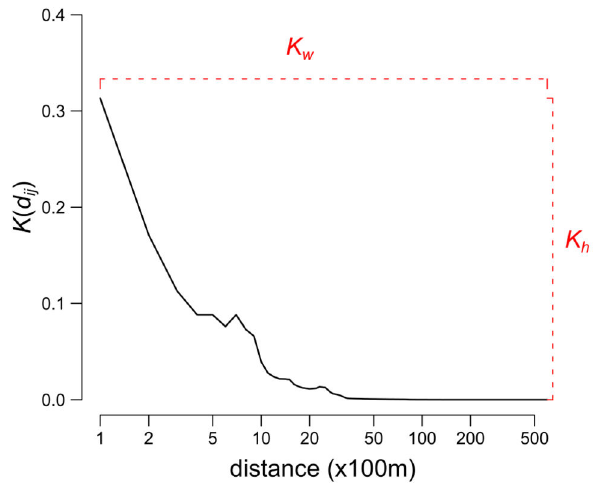
Figure 1. Between-farm transmission kernel function. Probability at which a given infected farm may infect a susceptible farm as a function of inter-farm distance rate d